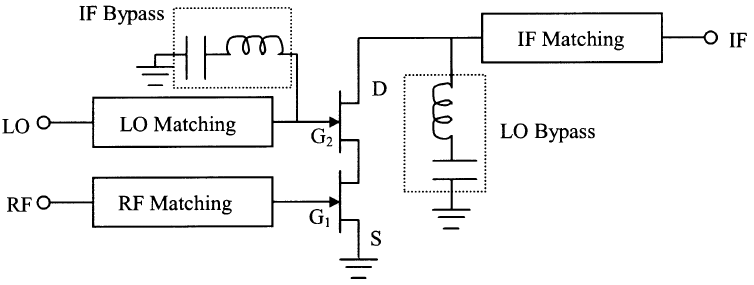
FIGURE 7 A mixer topology of two single-gate